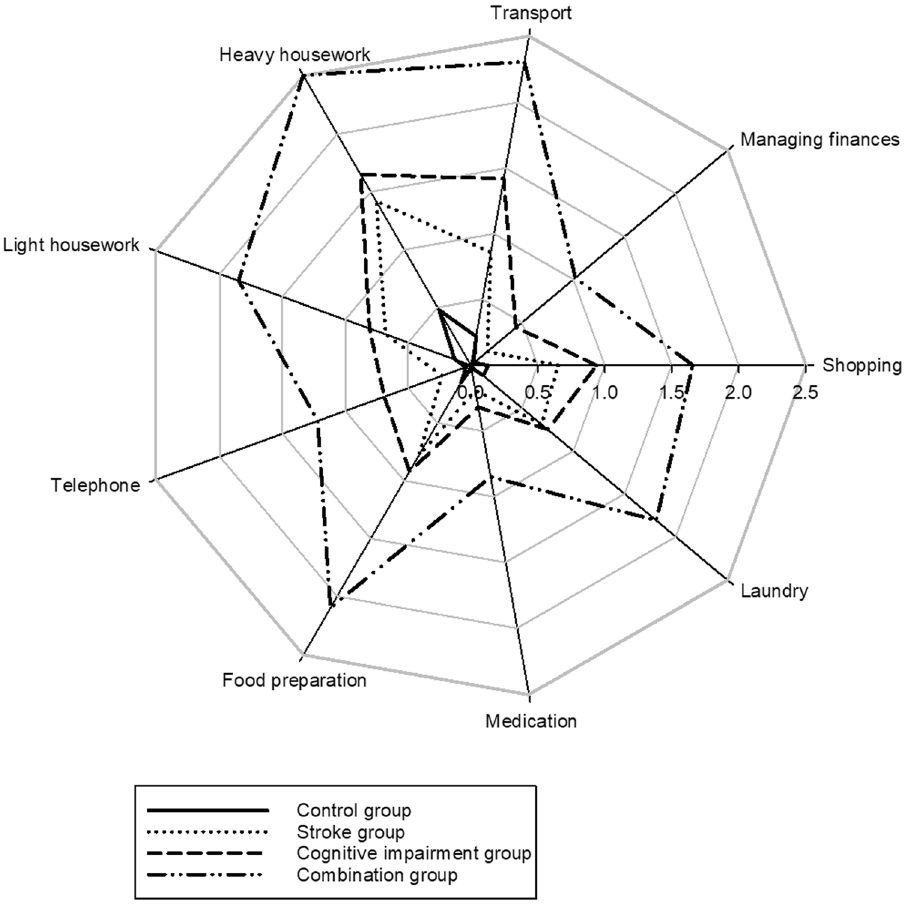
Figure 2. The level of difficulty for each instrumental activity of daily living (IADL) task presentated as mean values among the control, stroke, cognitive impairment, and combination groups. (0): no difficulty; (1): some difficulty; (2): great difficulty; and (3): inability to perform the